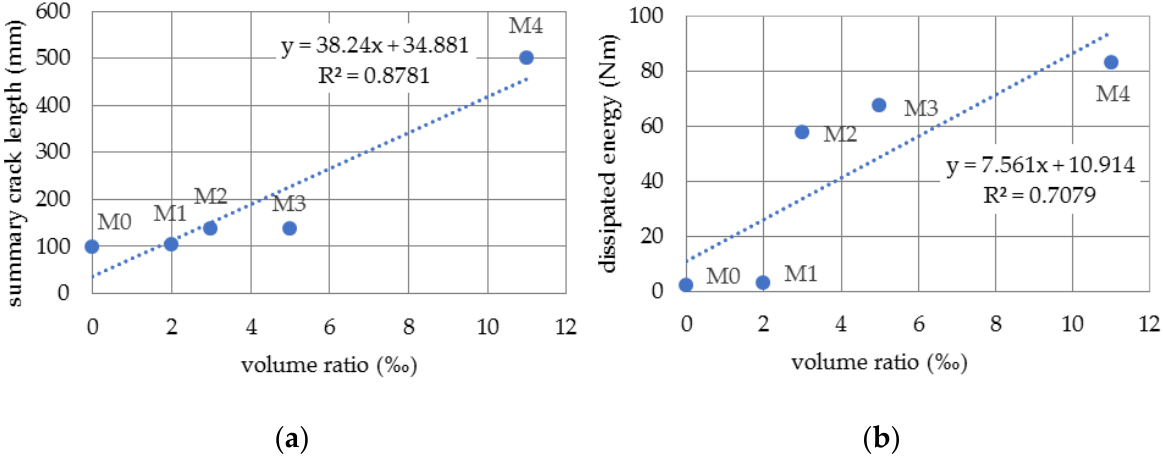
Figure 14. Correlation between ( a ) summary crack length, ( b ) dissipated energy and fiber volume ratio.